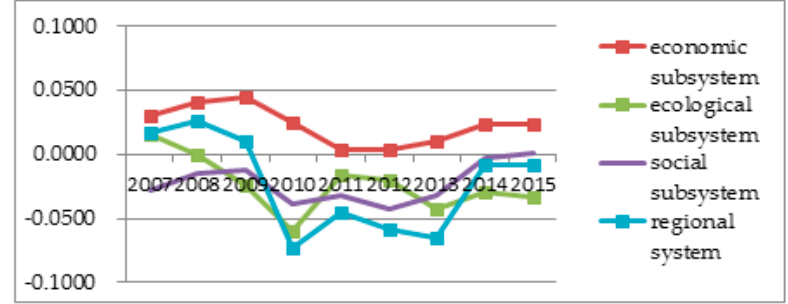
Figure 11. Entropy flow change in the regional sustainable development capacity.